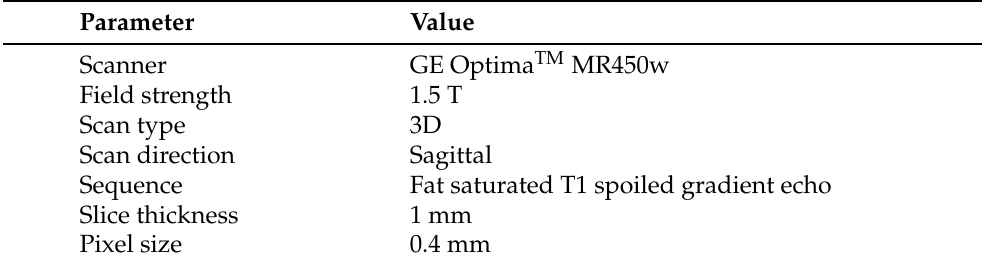
Table 1. Description of the MRI scan protocol.